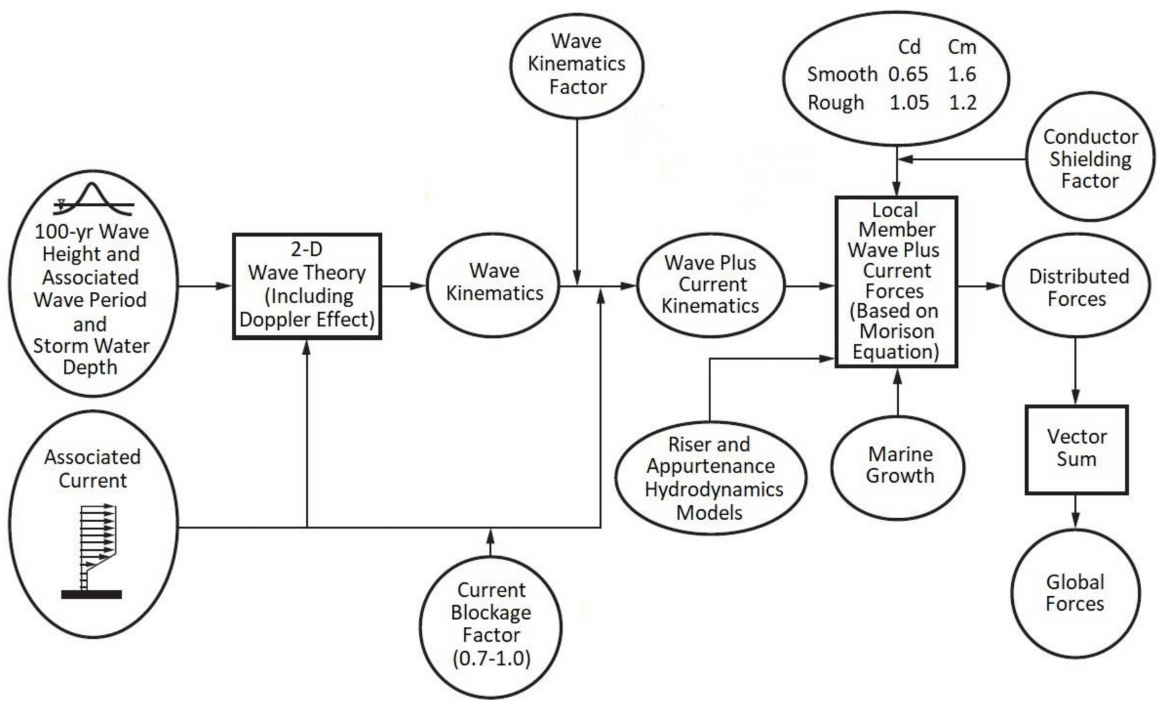
Figure 3. Wave force calculation